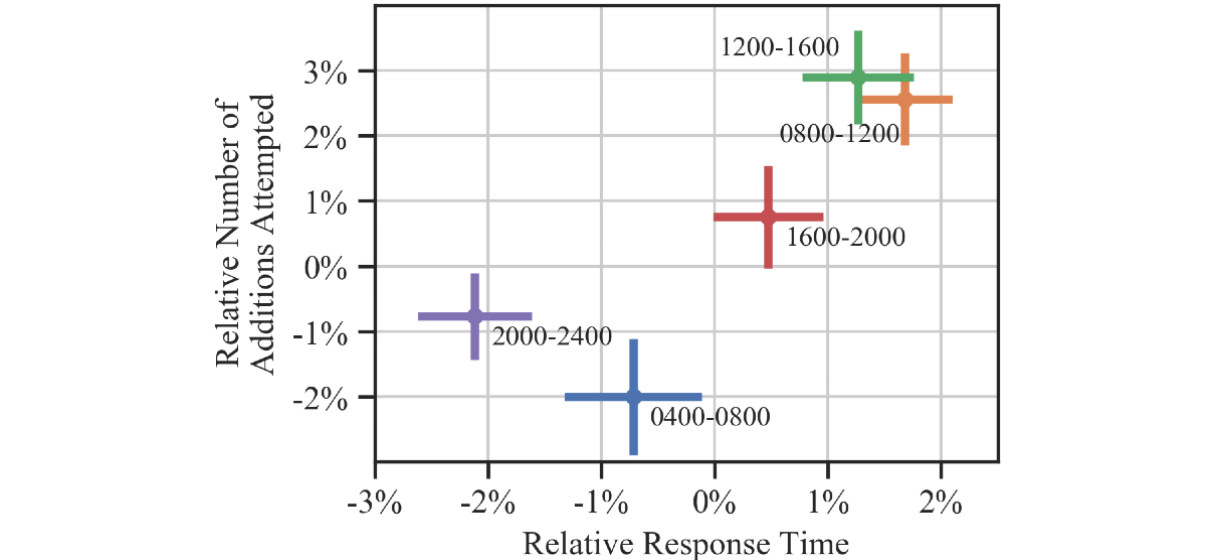
Figure 6. Fluctuations in cognitive performance by time of day. The x-axis represents alertness in terms of relative response times, and the y-axis represents cognitive throughput in terms of relative number of additions attempted. The dots represent the mean scores in the marked time range while the error bars represent the standard error of the mean along each